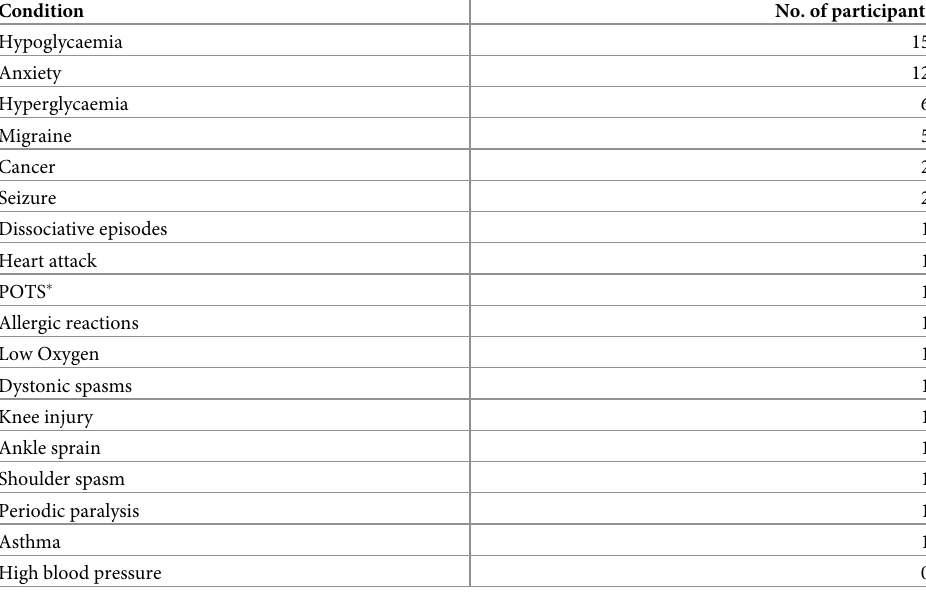
Table 7. The conditions to which dogs were reported to alert to other people and the number of participants that reported their dog alerted other people to those conditions.